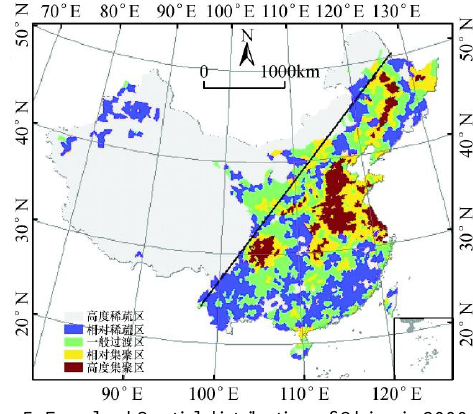
Figure 5. Farmland Spatial distribution of China in